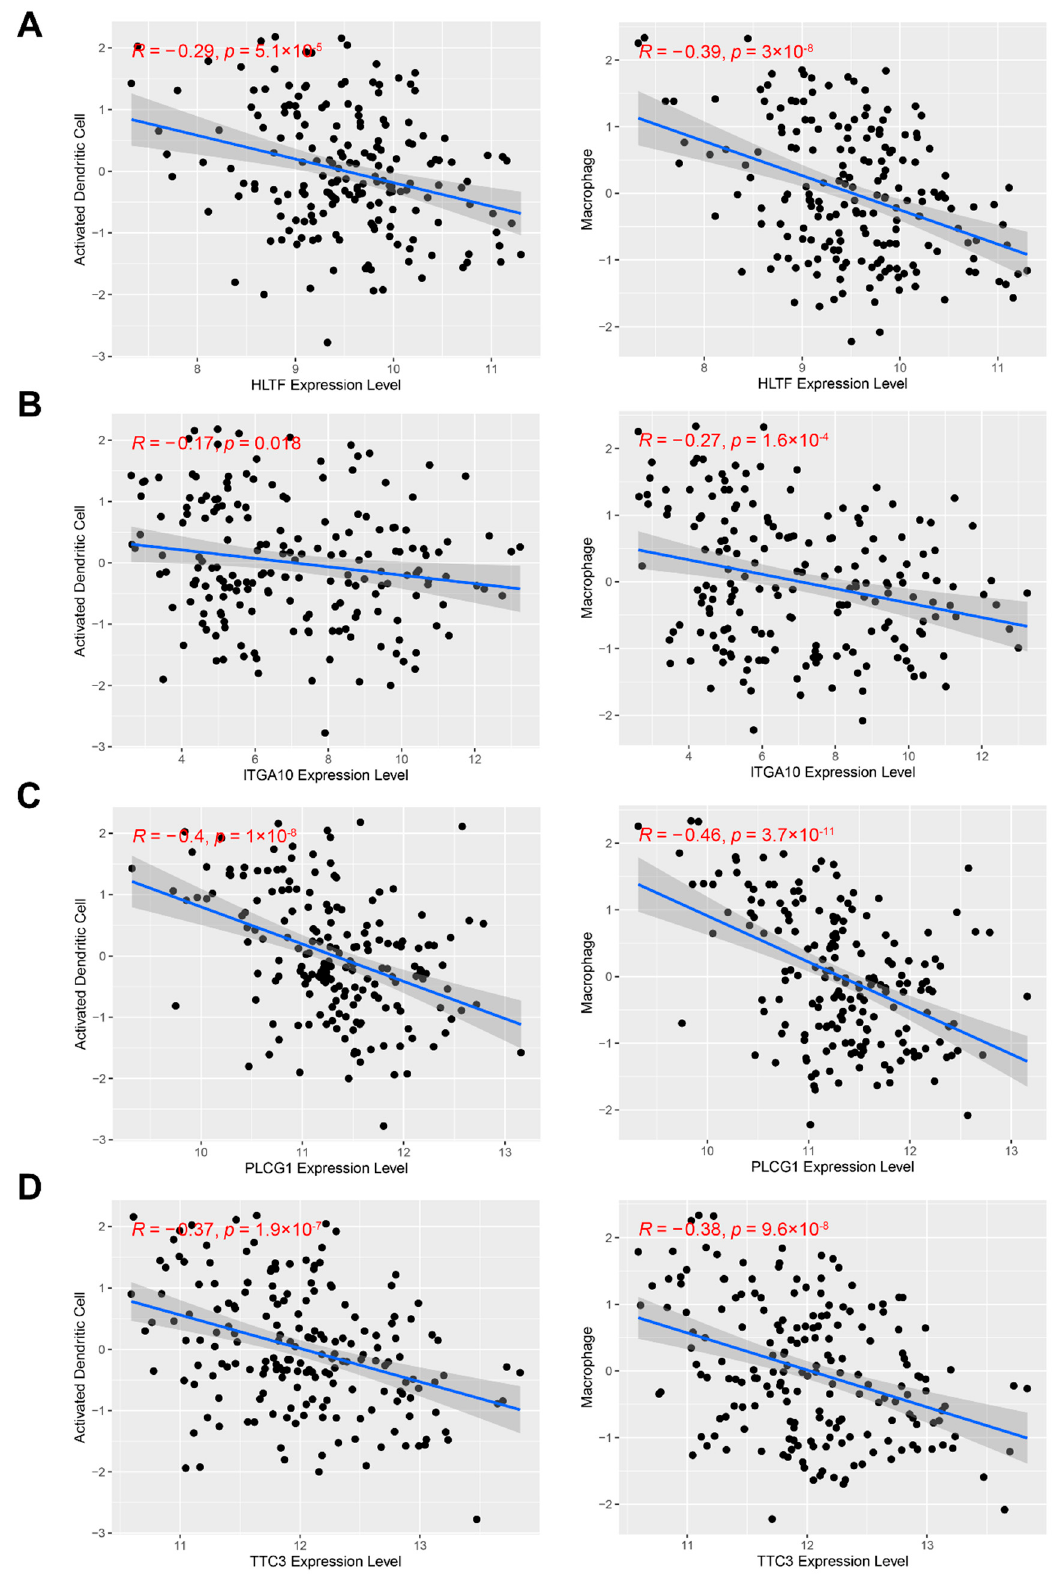
Figure 2. Identification of tumor antigens associated with the infiltration of antigen-presenting cells in TCGA cohort. ( A – D ) Correlation between HLTF ( A ), ITGA10 ( B ), PLCG1 ( C ), and TTC3 ( D ) expression and infiltration levels of dendritic cells and macrophages in STS.